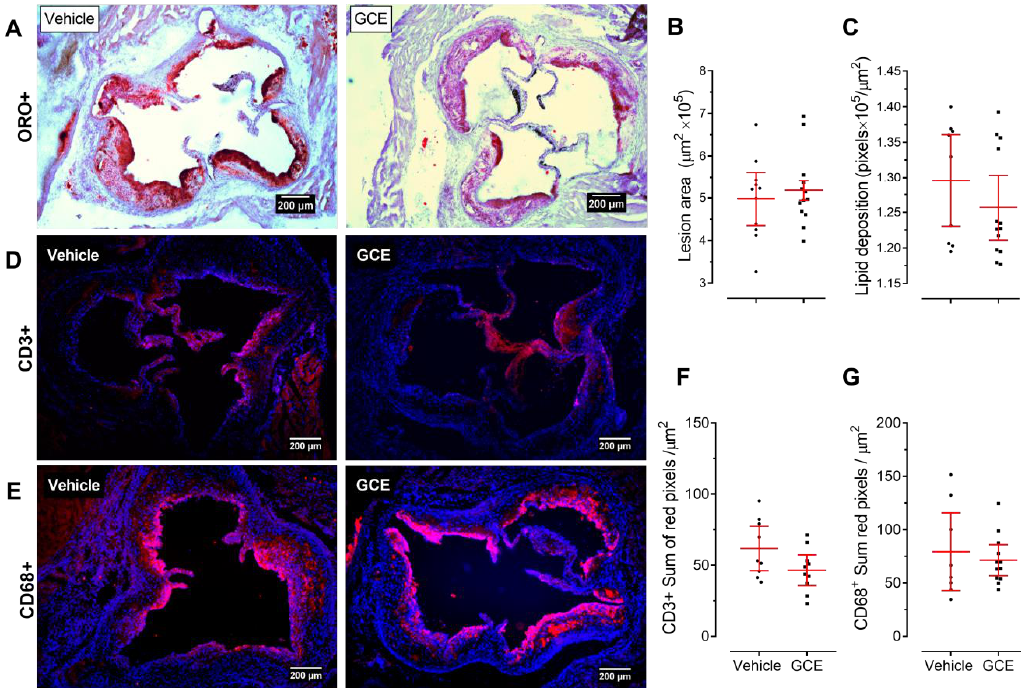
Figure 2. Green coffee extract (GCE) is not atheroprotective in ApoE -/- mice. Animals were fed an High-fat diet and treated orally with GCE (equivalent to 220 mg/kg of chlorogenic acids, three times a week) for 12 weeks, as shown in Figure 1. Vehicle (sterile water)-treated mice were used as negative controls. ( A ) Representative histopathological images of the valve area of the aortic sinus stained with Oil Red O/hematoxylin. ( B ) Area of atherosclerotic lesions and ( C ) plaque lipid content were assessed by Oil Red O staining (ORO + 1 × 10 5 / µ m 2 ). Aortic root sections were immunofluorescently stained with ( D ) anti-CD3 (upper panel) and ( E ) anti-CD68 (lower panel) monoclonal antibodies; representative merged images (4′,6-diamidino-2-phenylindole DAPI + Alexa 594 positive staining) are shown. In ( F , G ) the corresponding quantitative analyses of T cell infiltration or macrophage within the atherosclerotic plaque. Each point represents the average measurements (out of 6–8 sections) per animal (D–G). Values are expressed as the mean ± 95% confidence intervals. Unpaired t-tests did not show statistically significant differences between groups. Table 2. Blood chemistry and glucose metabolism parameters and indices in GCE- and vehicle-treated ApoE -/- mice.